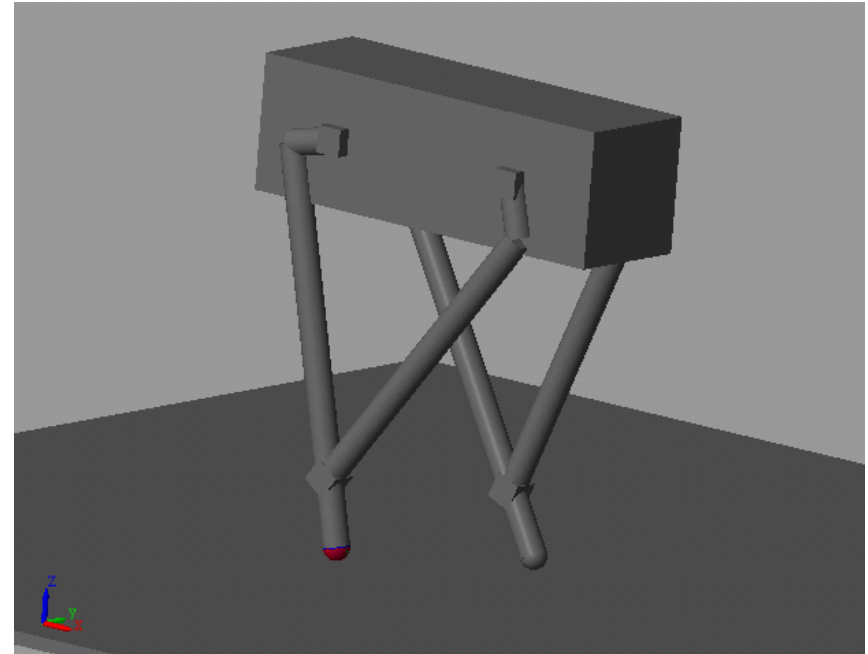
Figure 8. Robot model for